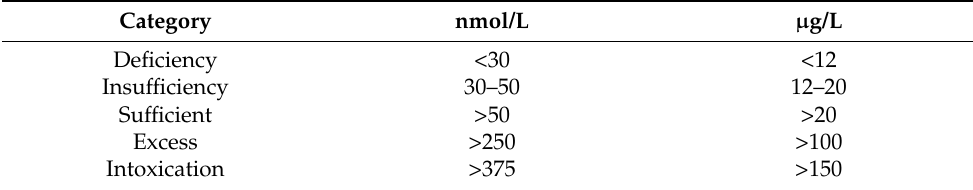
Table 1. Diagnostic cut-off points for 25-hydroxy-vitamin D (25(OH)D) concentrations, providing both commonly utilised 25(OH)D plasma concentrations. Table adapted from